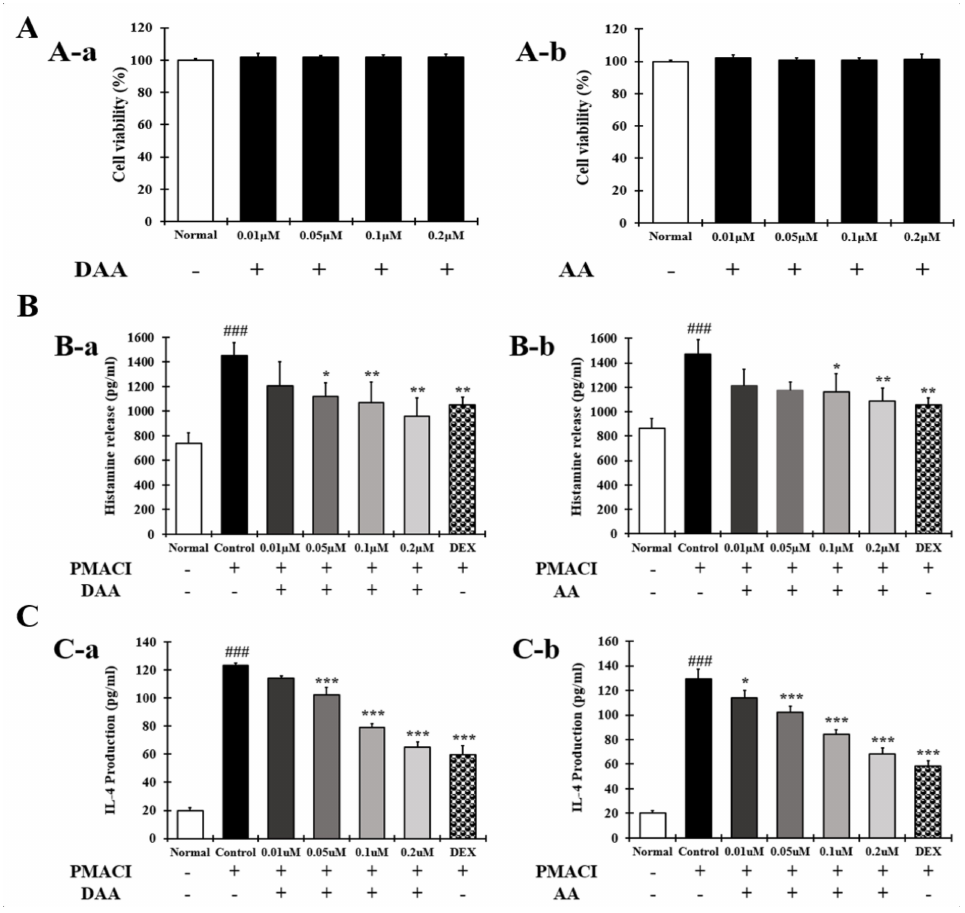
Figure 3. Effect of DAA and AA on HMC-1 cell viability and the levels of AD-related histamine and IL-4 in HMC-1 cells. ( A ) Viability of HMC-1 cells treated with DAA and AA. ( B ) Inhibitory effects of DAA and AA on the levels of histamine secreted by PMACI-treated HMC-1 cells. ( C ) Inhibitory effects of DAA and AA on the levels of IL-4 secreted by PMACI-treated HMC-1 cells. The levels of cytokines and chemokines in the supernatant of HMC-1 cells were determined by ELISA. The results are expressed as the mean ± SD (n = 4). ### p < 0.001 vs. normal; * p < 0.05, ** p < 0.01, and *** p < 0.001 vs. control; DAA was used at 0.01 µ M, 0.05 µ M, 0.1 µ M, and 0.2 µ M. DEX, the positive control, was used at 0.1 µ